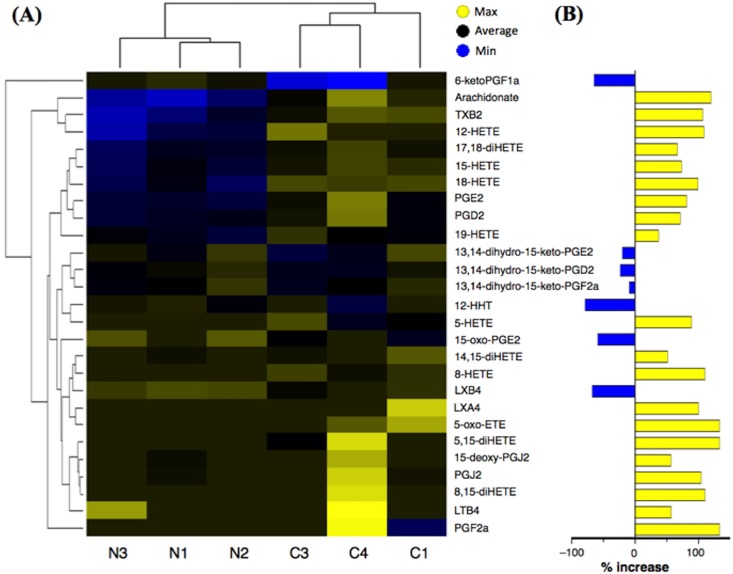
Profiling of changes in arachidonic acid metabolites in bronchoalveolar lavage (BAL) fluids of the antigen-challenged mice. Twenty-four hours after the last antigen challenge, BAL fluids were obtained from respective mice. The BAL fluid of each mouse (3 animals/group) was subjected to the LC/MS/MS analysis as described in METHODS. (A) Hierarchical cluster analysis of arachidonic acid metabolites measured. Each row represents a metabolite and each column represents an individual mouse. N and C represent the normal control and the repeatedly antigen-challenged groups, respectively. Each group contains three different animals. Colors represent fold change in each individual, with yellow indicating increased metabolites and blue indicating decreased metabolites with respect to the average of the normal control animals. (B) Summary of % changes in the metabolite levels in BAL fluids of antigen-challenged mice. Yellow columns indicate % increases and blue columns indicate % decreases of the indicated arachidonic acid metabolites.